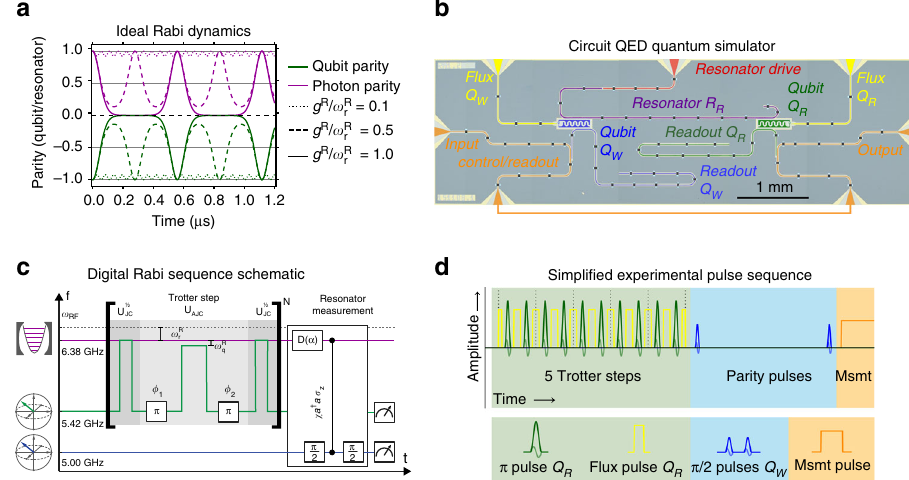
Fig. 1 Digital-analogue quantum Rabi simulation using phase-controlled parameter tuning. a Parity dynamics of the ideal quantum Rabi model in the (cid:6) ¼ 0 degenerate-qubit case ω R for qubit (green) and resonator (red) in coupling regimes: r ¼ g R = ω R q example, g was chosen to match the experimentally observed value of g /2 π = 1.79 MHz. b Two-transmon, three-resonator cQED chip (detailed description in Supplementary Notes 2 and 3). c Sequence schematic for second-order Trotterisation. The rotating frame de fi ning the simulated resonator frequency ( ω r ) is controlled via the Q R bit- fl ip pulse phases. d Example simpli fi ed experimental pulse sequence for 5 Trotter steps followed by a photon parity